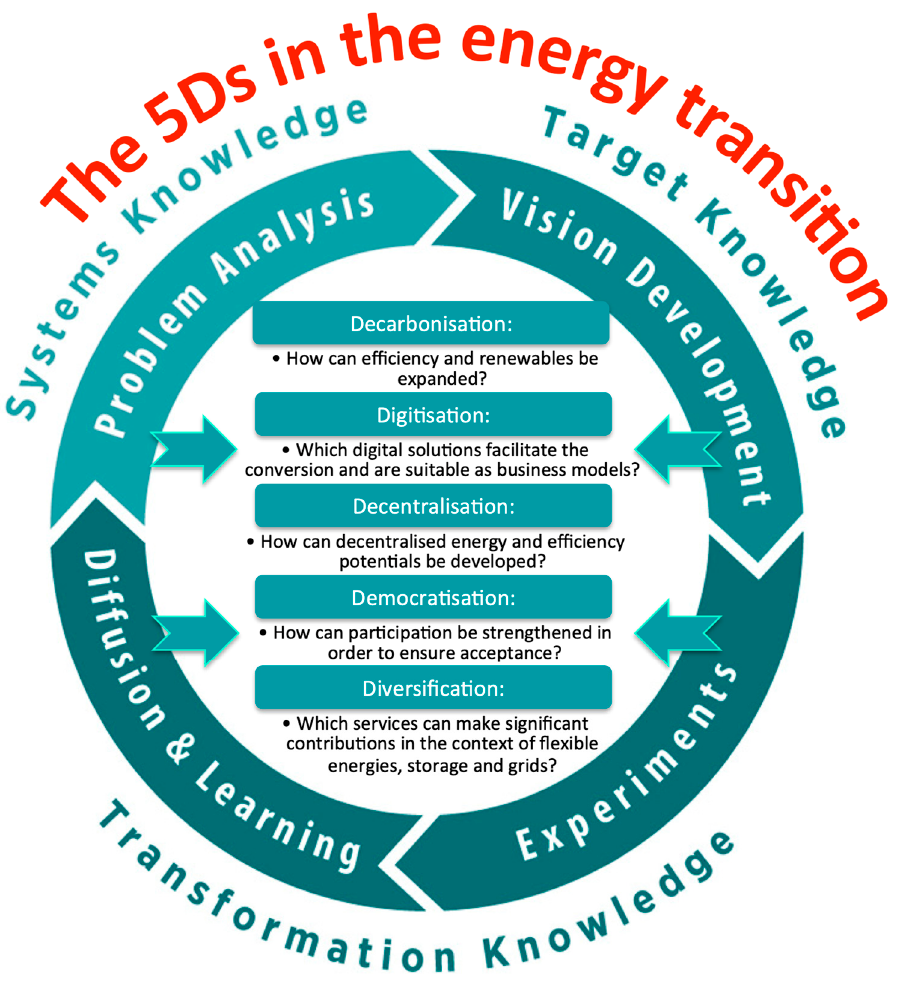
Figure 6. Overview of a results-oriented transition process (authors’ illustration).